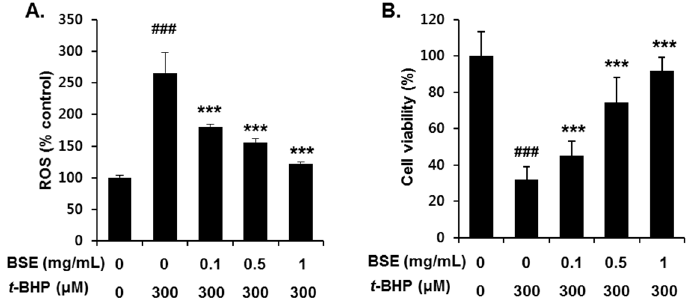
Figure 4. Inhibition of t -BHP-induced ( A ) ROS generation and ( B ) cell viability by barley sprout extract (BSE) in HepG2 cells. Cells were pretreated with BSE ranging from 0.1 mg/mL to 1 mg/mL for 3 h before treatment with t -BHP (300 μ M) for 1 h to measure ROS generation. To determine cell viability, the cells were pretreated with BSE for 12 h before treatment with t -BHP (300 μ M) for 18 h. Each value represents the mean ± SD. ### Significantly different from vehicle-treated cells, p < 0.001. *** Significantly different from t -BHP-treated cells, p < 0.001 (Student’s t -test).